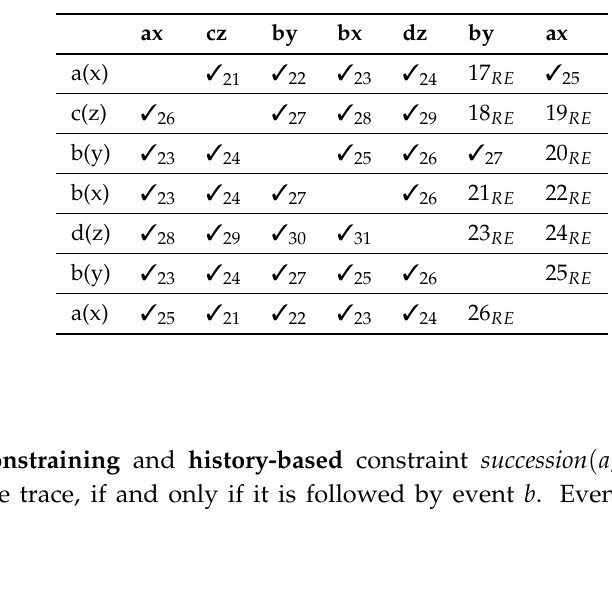
Table 19. MR-I results for coExistence constraints